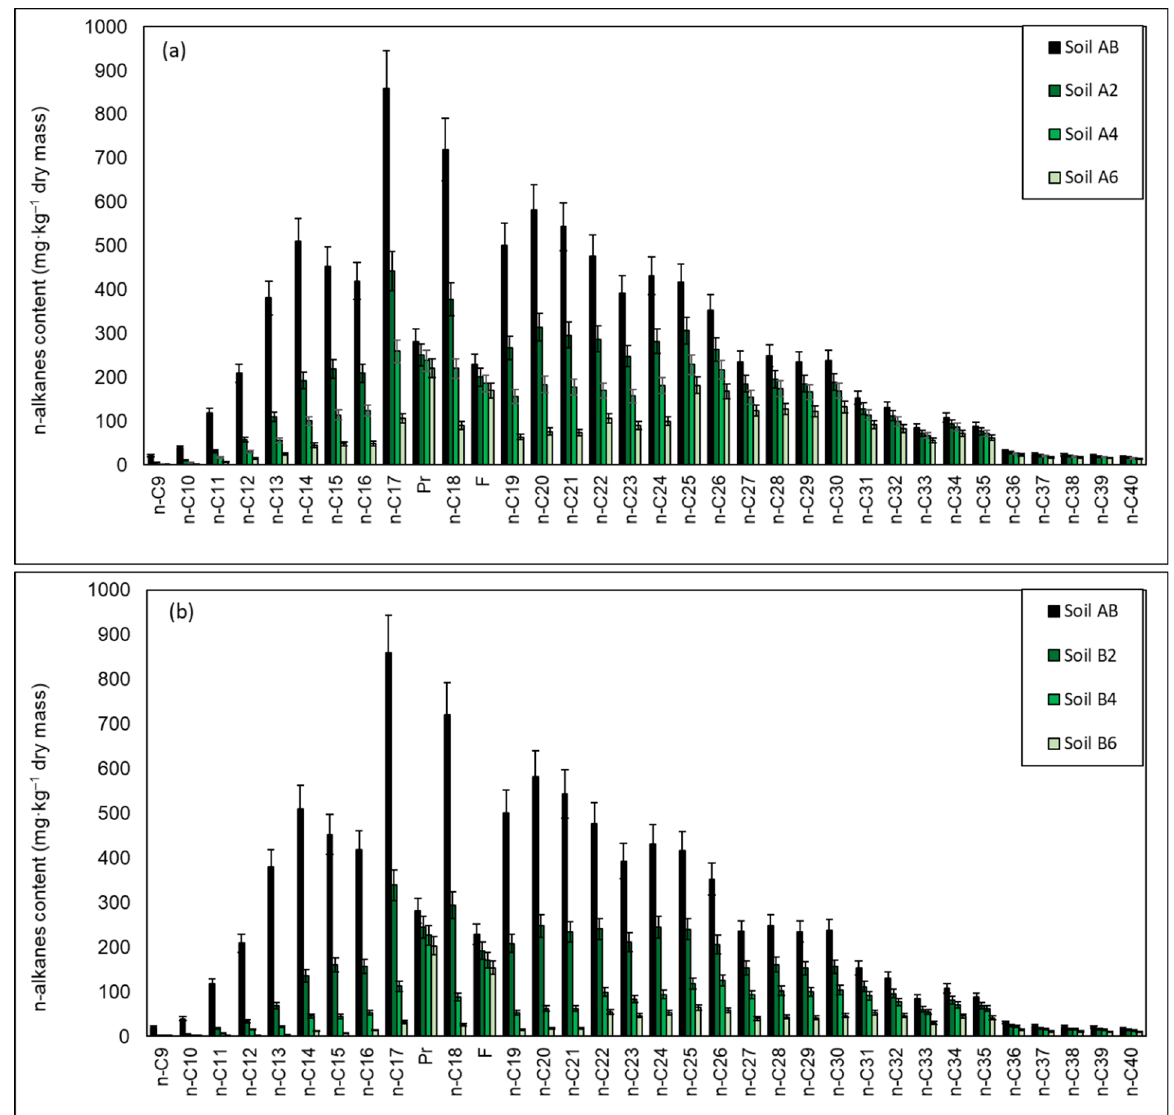
Figure 3. Residual content of n-alkanes in soil contaminated petroleum hydrocarbons inoculated ( a ) biopreparation A1, ( b ) biopreparation A1 with the addition of γ -PGA after 2 (Soil A2/Soil B2), 4 (Soil A4/Soil B4) and 6 (Soil A6/Soil B6) months of the biodegradation process carried out in